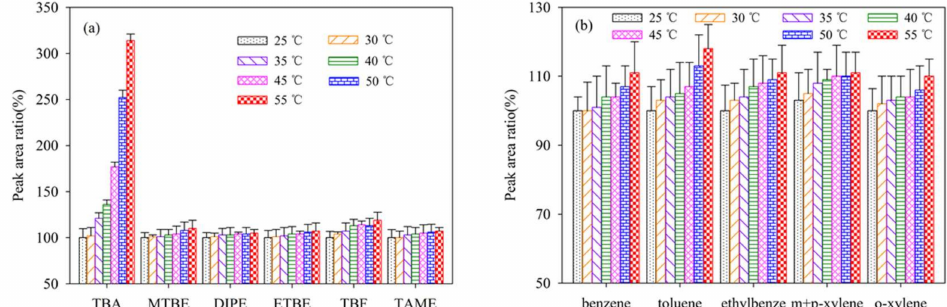
Figure 2. E ff ect of sample temperature on signal intensities of the twelve analytes (20 µ g / L). The peak area at the sample temperature of 25 ◦ C is used as a reference (100%). ( a ) the peak area ratio of TBA, MTBE, DIPE, ETBE, TBF, and TAME; ( b ) the peak area ratio of benzene, toluene, ethylbenze, m + p–xylene, and